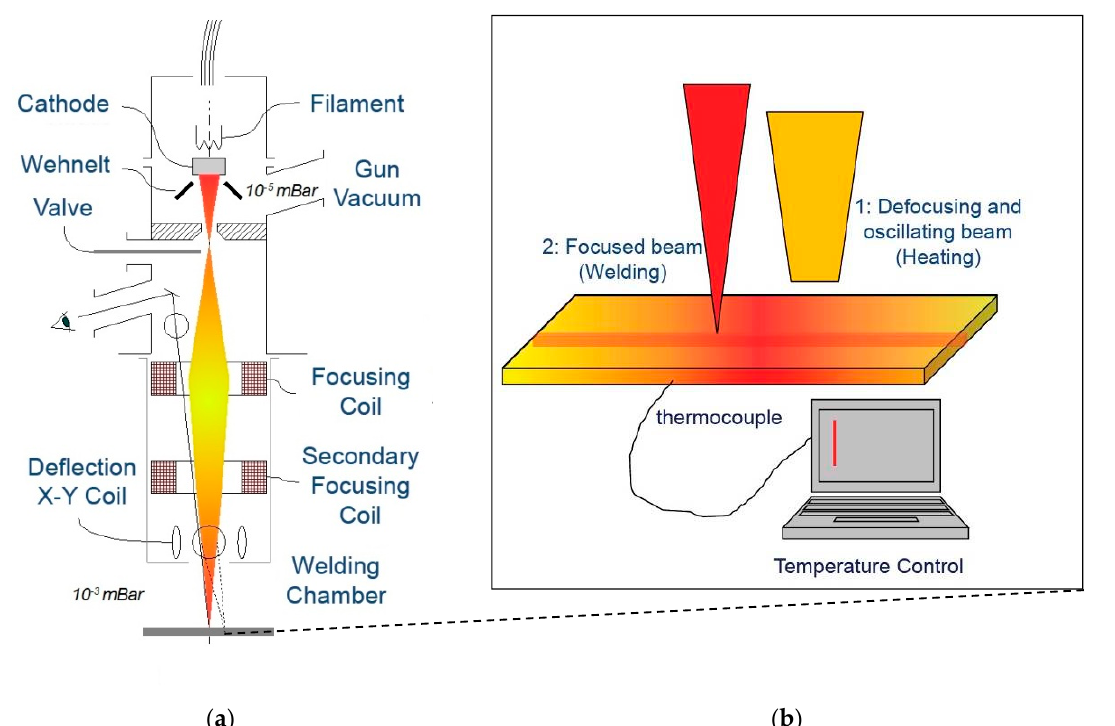
Figure 1. Sketch of the apparatus used for realizing electron beam (EB) welds ( a ). Detail of the workpiece ( b ): a thermocouple measures the temperature of the material that is pre-heated by defocusing and wobbling the electron